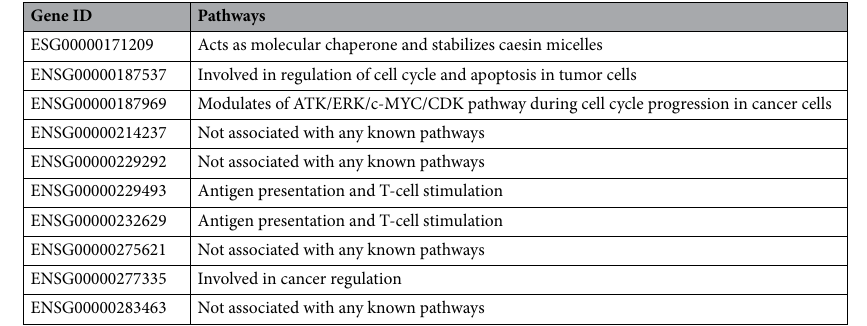
Table 3. LDEGs identified in module 70 for severe versus moderate COVID-19 comparison. These LDEGs, depleted in expression level in severe COVID-19 patients (relative to moderate COVID-19 patients), have not yet been implicated in COVID-19 pathogenesis.